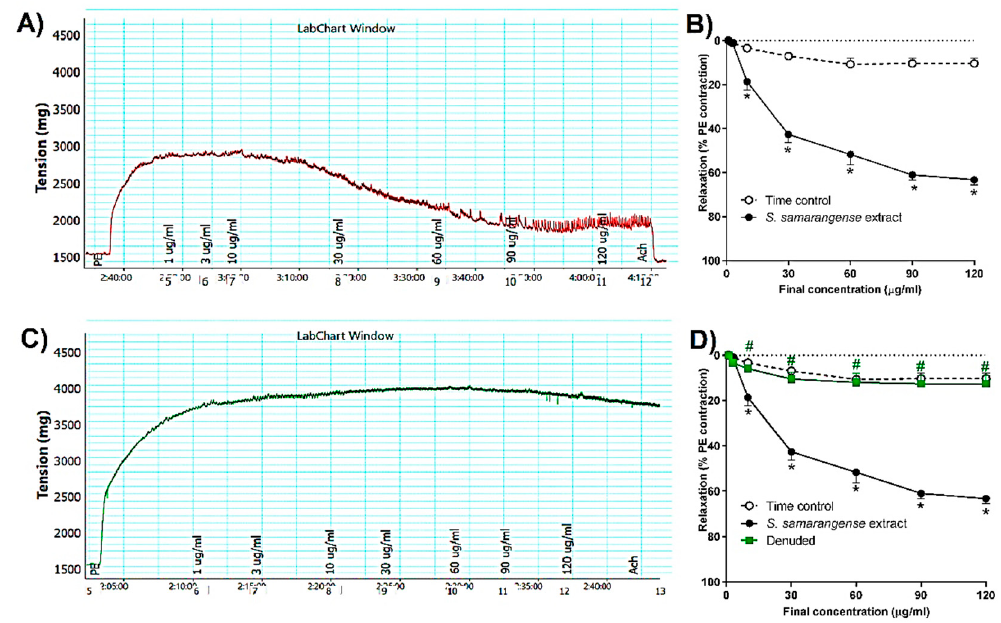
Figure 2. Effects of the cumulative addition of S. samarangense extract doses (1–120 g/mL) on isolated aortae from control rats that had been pre-constricted by phenylephrine (PE, 10 M). ( A ) typical tracing of S. samarangense extract’s dilation-inducing effects on PE-preconstricted aortae with healthy endothelium, ( B ) concentration response curve showing the vasodilating effect of S. samarangense extract on PE preconstricted aortae with intact endothelium compared with appropriate time controls, ( C ) an illustration of the effect of S. samarangense extract’s vasodilator on PE-precontracted aortae with denuded endothelium, and ( D ) concentration response curve showing the vasodilating effect of S. samarangense extract on PE preconstricted aortae with denuded endothelium compared with its vasodilating effect on PE pre-constricted aortae with the intact endothelium. The results are displayed as the mean ± standard error of six animals. In comparison to the time control values, * p < 0.05; in comparison to the effect of the S. samarangense extract on intact endothelium values, # p < 0.05.